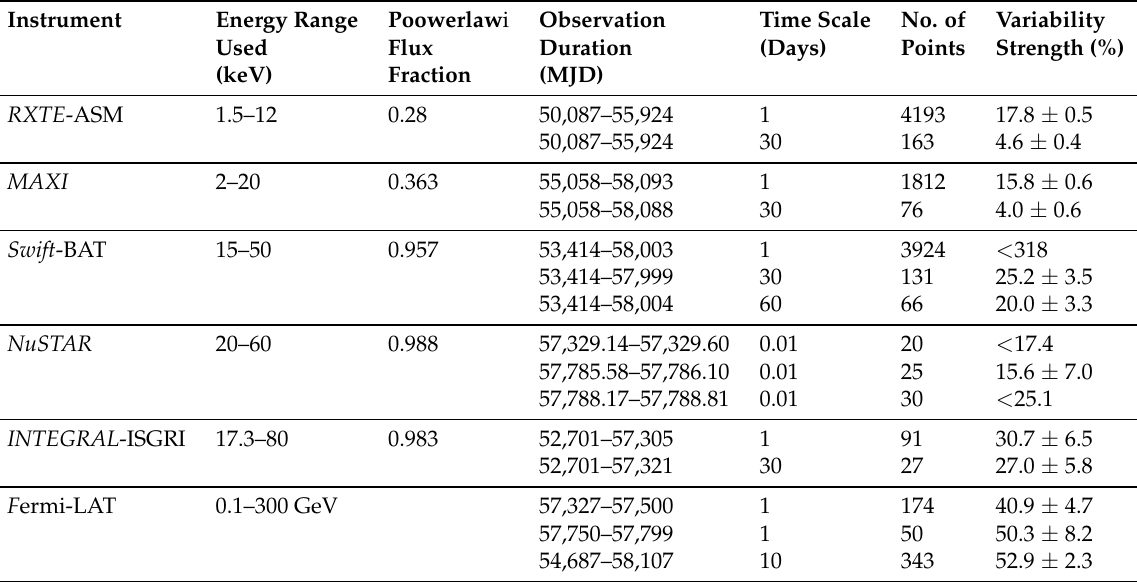
Table 5. X-ray and gamma-ray variability on various time